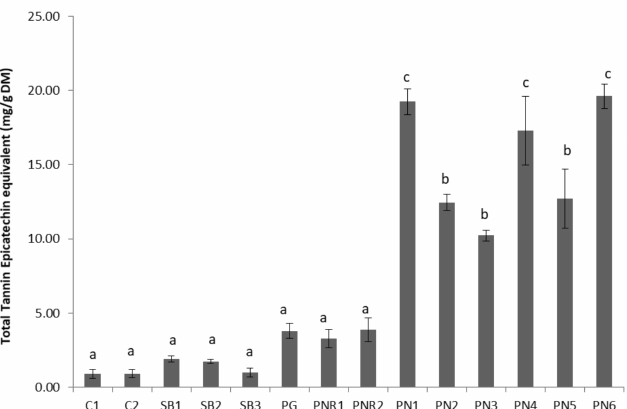
Figure 3. Total tannin content (epicatechin equivalent/g FDM) of different wine lees extracts.